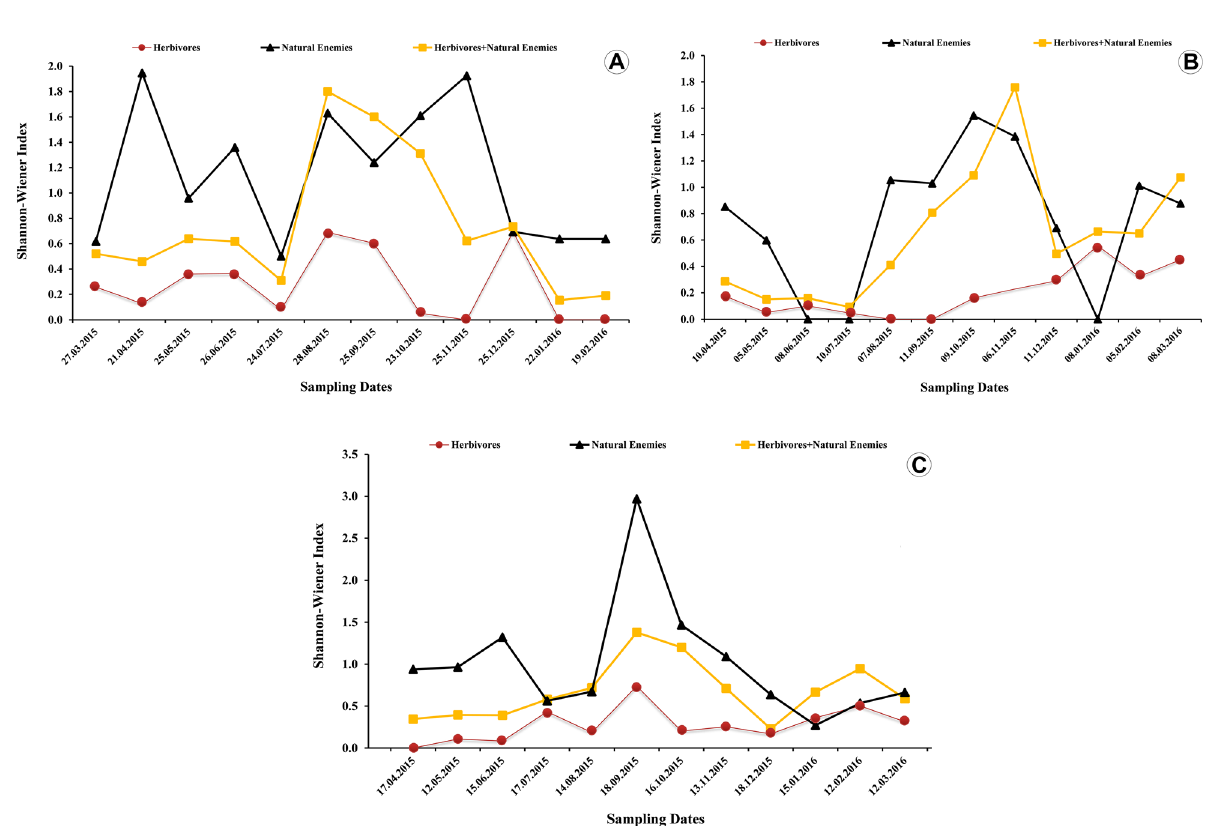
Figure 2. Time graph showing temporal variation in Shannon–Wiener index. Insect diversity associated with Platycladus orientalis (L.) in ( A ) Sadaf, ( B ) Sajjad, and ( C ) Lashkar, three urban green spaces in Mashhad city,